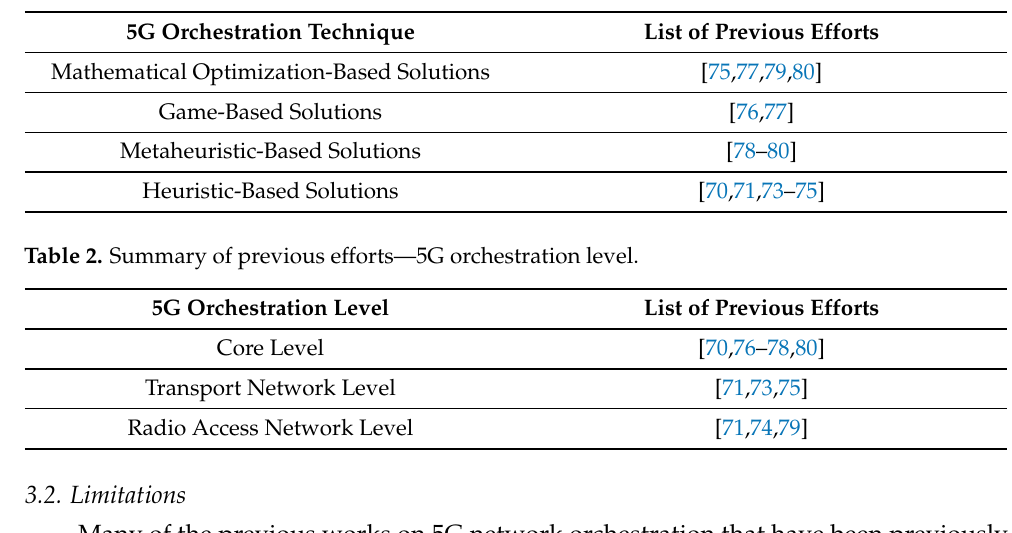
Table 1. Summary of previous efforts—5G orchestration methodology.